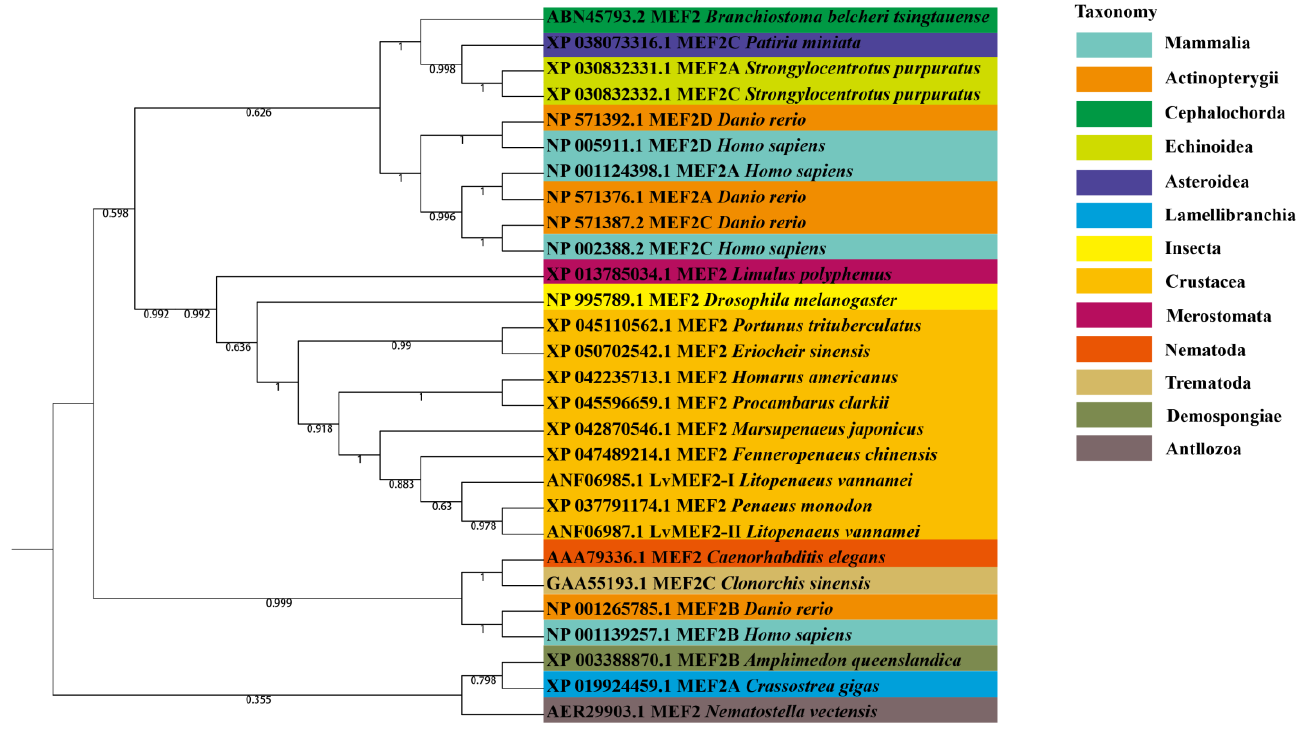
Figure 3. Phylogenetic analysis of LvMEF2 and MEF2s of other species. The bootstrap values are given at each branch node. Different colors represent different classes.